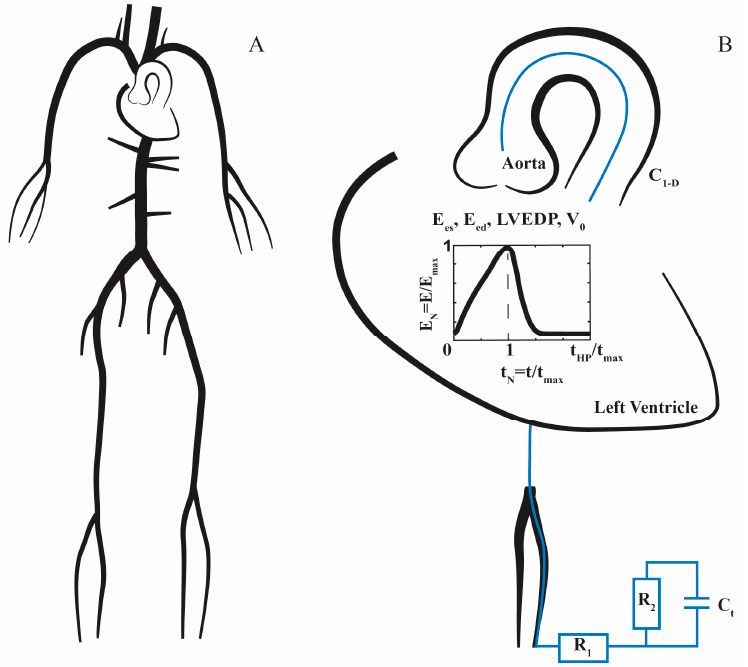
Figure 1. ( A ) 1D model of the cardiovascular system with main systemic arteries; ( B ) at the proximal site, the left ventricular is modeled according to the varying elastance model. The instantaneous elastance of the left ventricle is calculated for a given E es , E ed , heart period (t HP ) and maximum elastance time (t max ) by exploiting the normalized varying elastance (E N ). Left ventricular end-diastolic pressure (LVEDP) and dead volume (V 0 ) are the additional parameters needed to construct the pressure–volume loop of a patient. At the distal boundaries, the 1D model is coupled to a three-element Windkessel model, which includes terminal compliance (C t ), proximal resistance (R 1 ) and distal resistance (R 2 ). Compliances of the main systemic arteries are represented as C 1-D